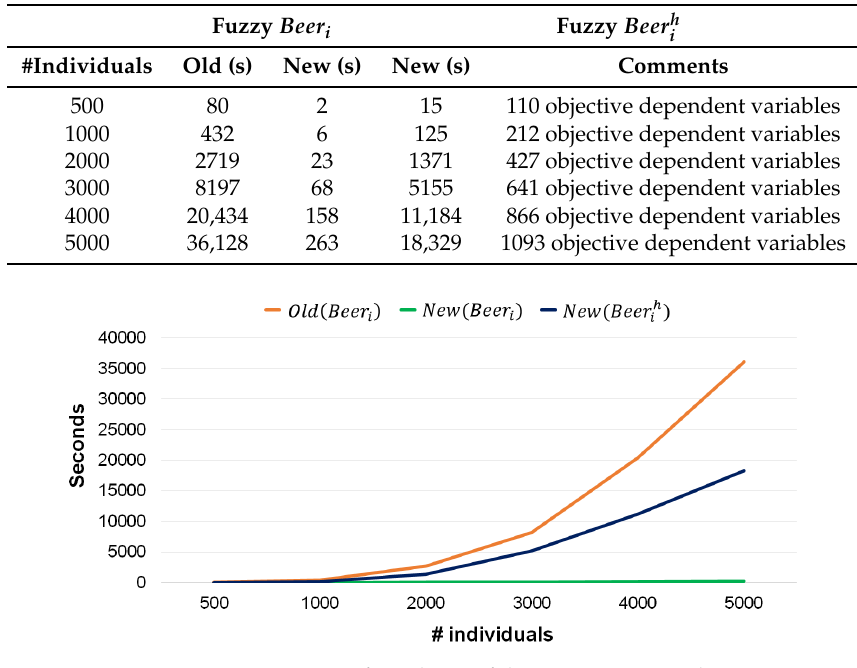
Figure 2. Running time for subsets of the Fuzzy Beer ontology. Table 9. Running time (s) for subsets of the inconsistent Fuzzy Beer